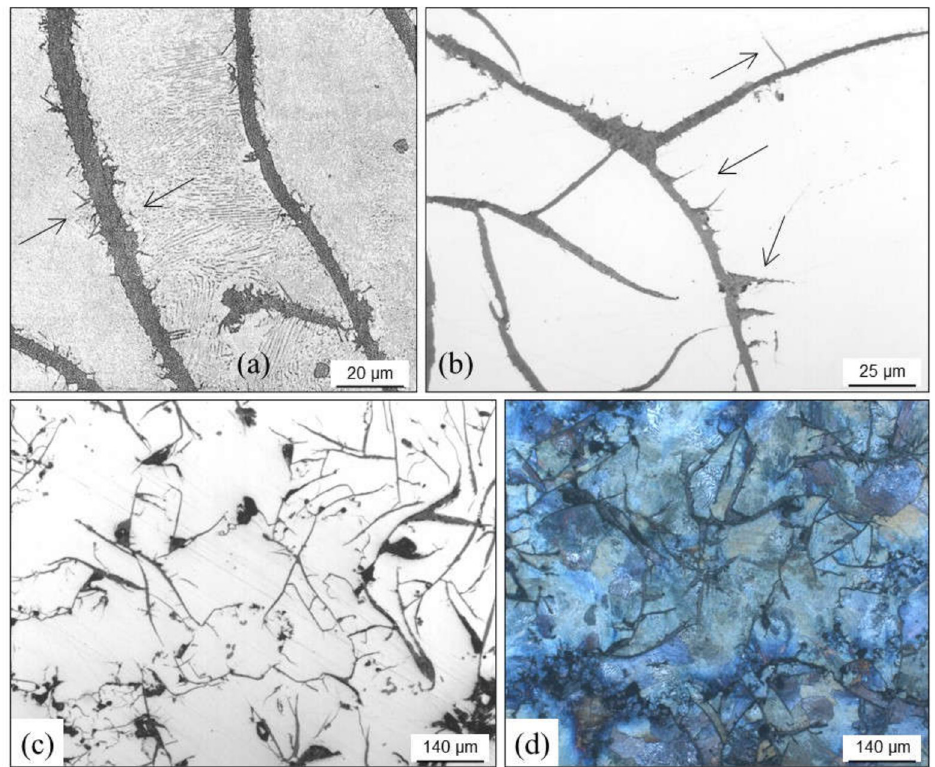
Figure 86. Examples of Widmanstätten graphite in fully pearlitic grey iron castings with graphite branches ( a , b ) and graphite aggregates ( c , d